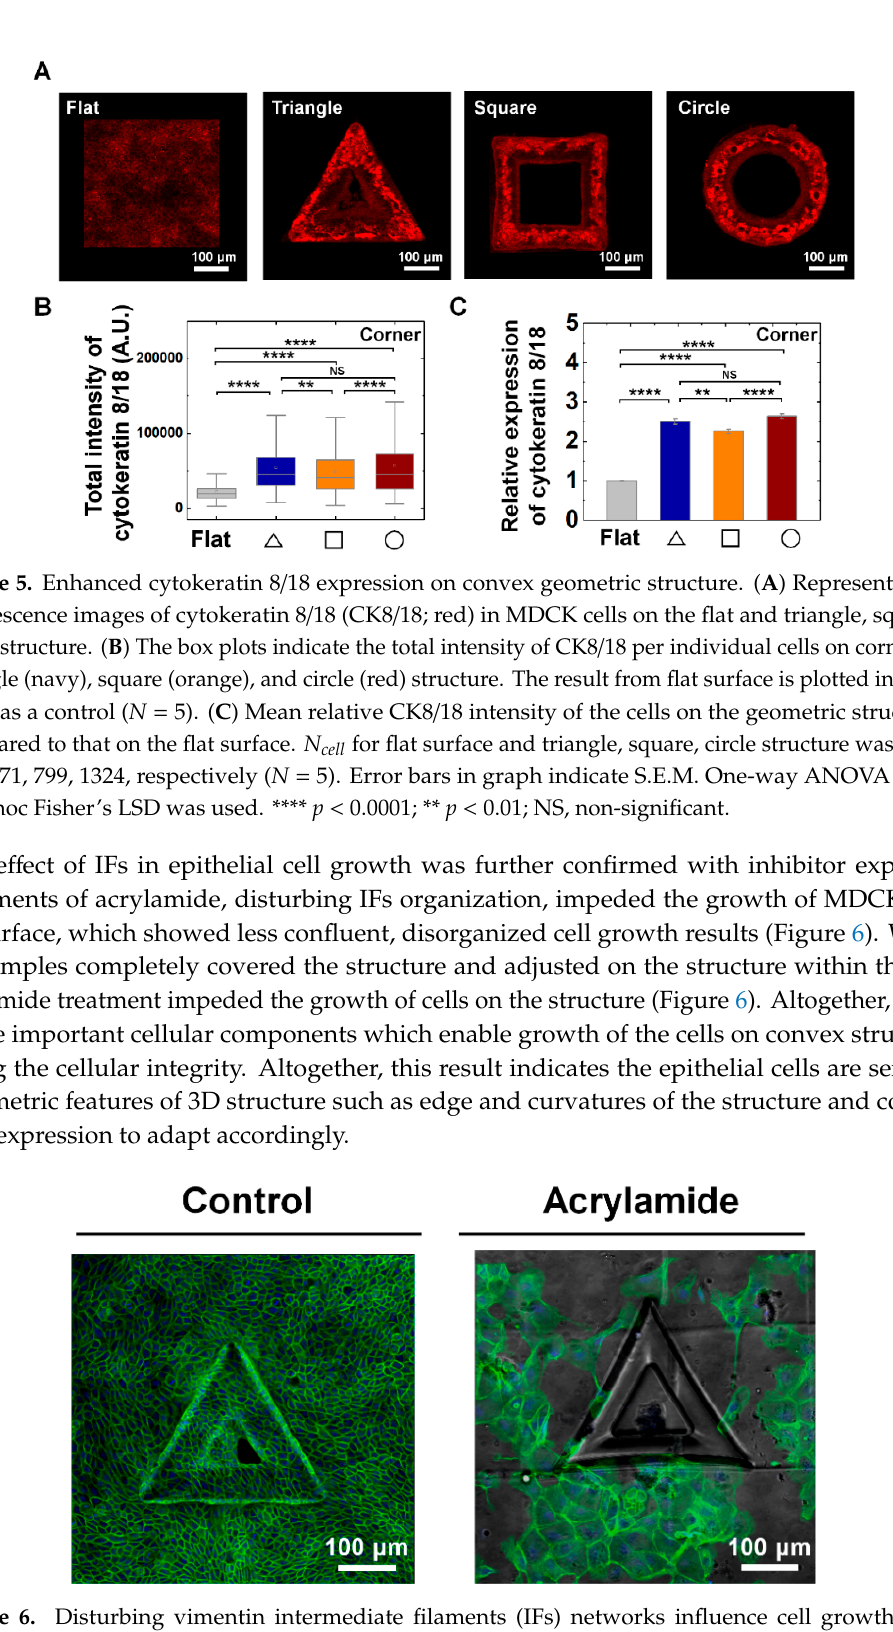
Figure 6. Disturbing vimentin intermediate filaments (IFs) networks influence cell growth and adaptation on convex structure. Representative fluorescence images of MDCK cells after 3 days of incubation without- and with 2mM acrylamide, causing collapse of vimentin filaments organization. F-actin (green) and nucleus (blue) were stained with phalloidin-FITC and DAPI, respectively.